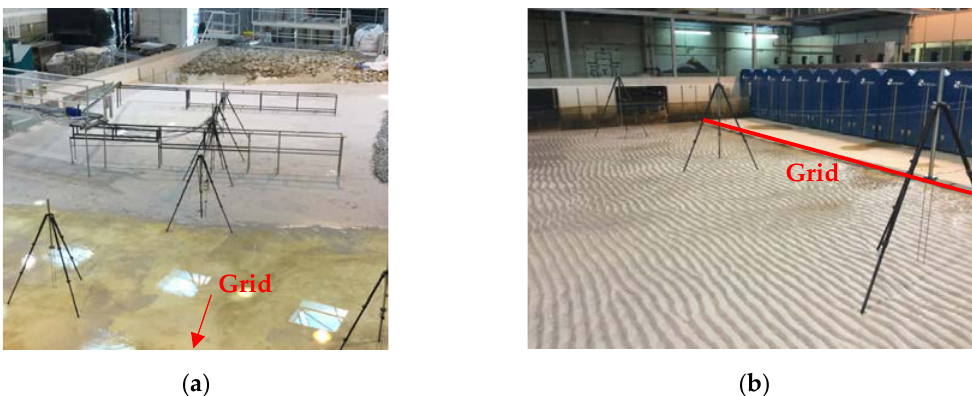
Figure 12. Offshore beach limits for scenario A: ( a ) Initial offshore profile limit (A.1); ( b ) Final offshore profile limit (A.1).